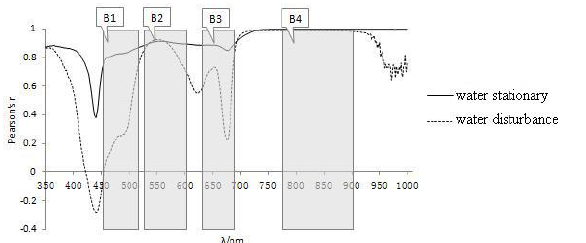
Figure 1 Correlation coefficient between Microcystic aerugino- sa spectral reflectance and chlorophyll-a concentration 3.2 Correlation of broad band vegetation indices and Mi- crocystic aeruginosa chlorophyll-a Under the condition of water disturbance and stationary, corre- lation coefficient (r>0.9) of Microcystic aeruginosa chloro- phyll-a with band 2, band 4 are both very high. At band 1 and band 3, correlation coefficient (r<0.5) is low under the condition of water disturbance. On the contrary, r is more than 0.85 under the condition of water stationary (Figure